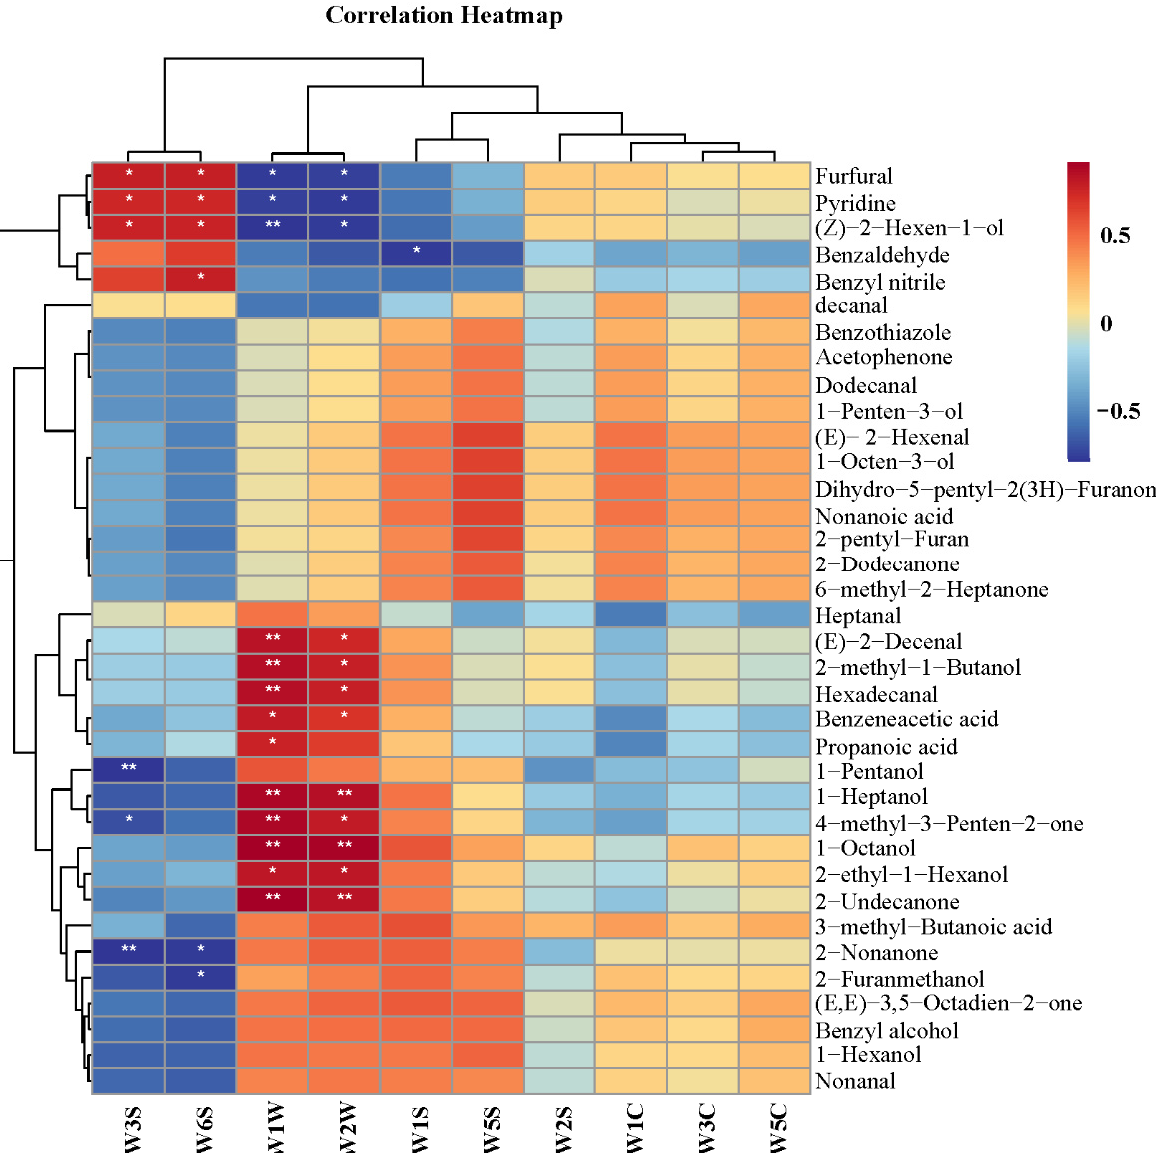
Figure 4. A correlation heatmap of electronic nose results and non-volatile compounds of MRPs with different polar lipids. Note: *: p < 0.05; **: p < 0.01.